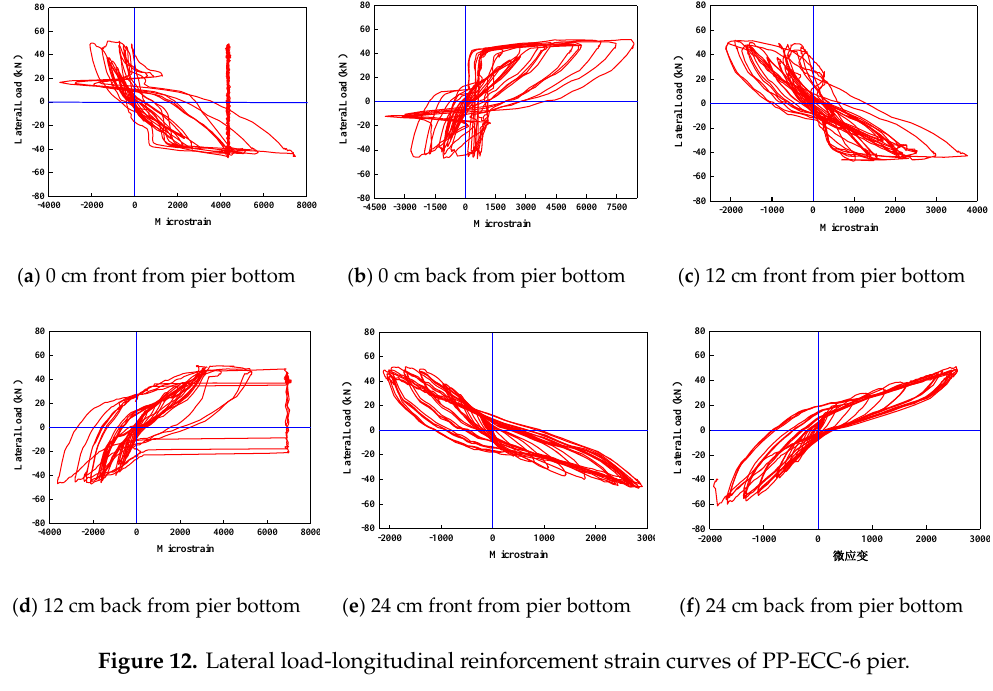
Figure 12. Lateral load-longitudinal reinforcement strain curves of PP-ECC-6 pier.